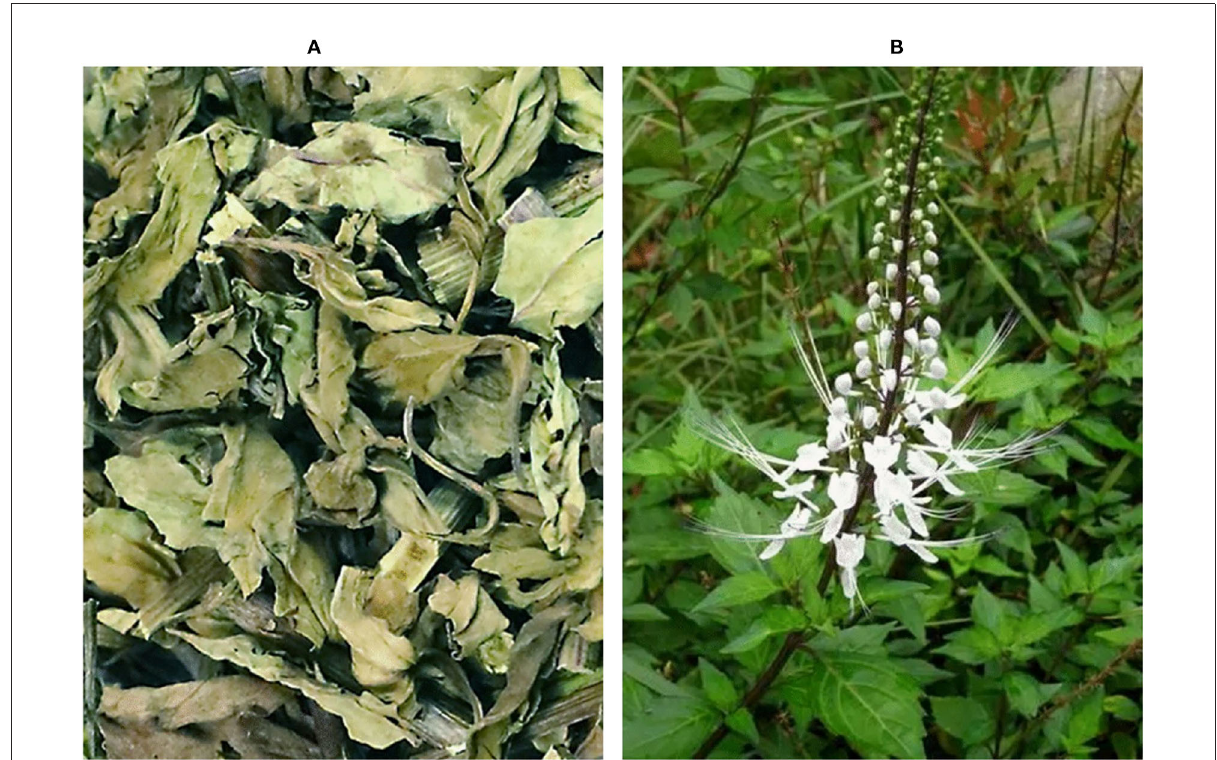
FIGURE1 Observation diagram of Clerodendranthus spicatus (Thunb.) C. Y. Wu, (A) Dried Clerodendranthus spicatus (Thunb.) C. Y. Wu, commodity condition; (B) Clerodendranthus spicatus (Thunb.) C. Y. Wu in vegetative